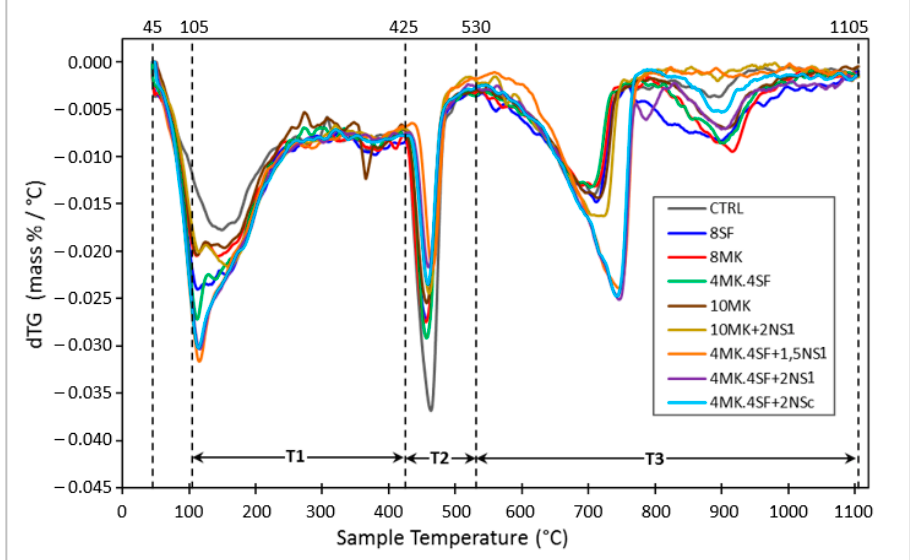
Figure 8. Curves of the thermogravimetric derivative according to temperature ranges.